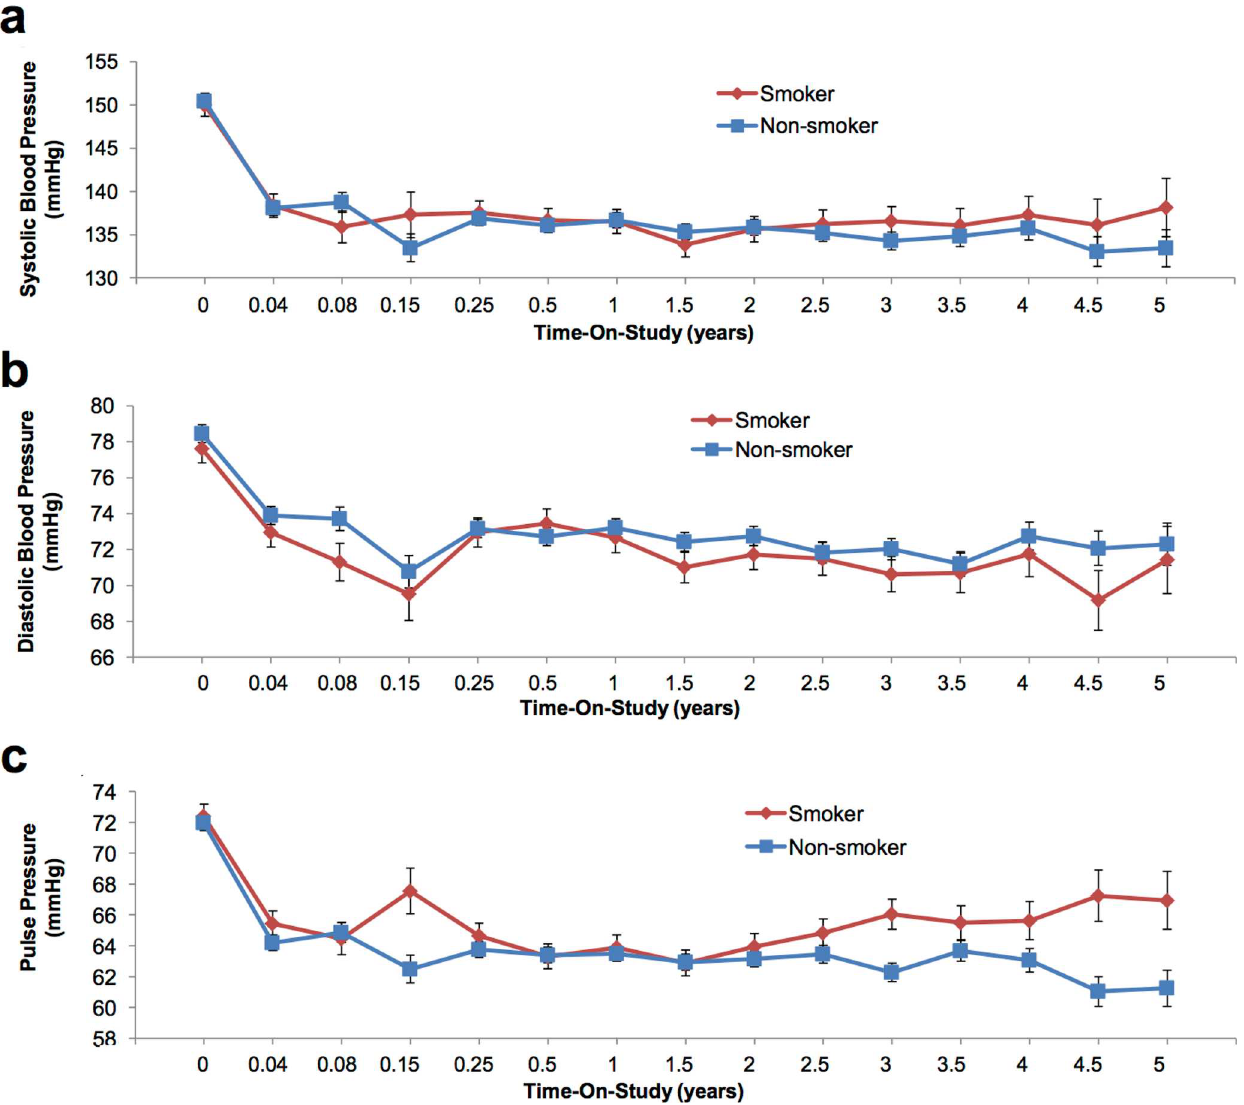
Fig 6. Longitudinal effect on blood pressure for smokersversus non-smokers. Graphs represent the following:a): systolic blood pressure (mmHg); b): diastolic bloodpressure (mmHg); and c): pulse pressure(mmHg). Mean ± SD for the patient data from baselinethrough follow-up are given. No significantdifferences were